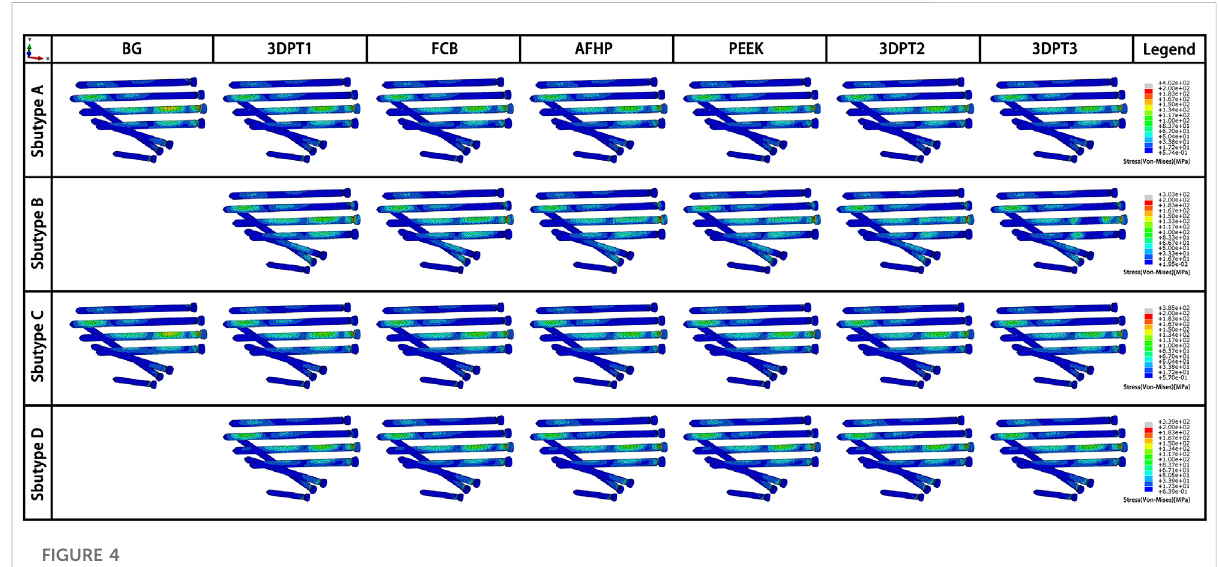
FIGURE 4 Stress fi elds(von Mises)in screw inan oblique downward view for the26simulated scenarios. The maximumstress values in thescrew for each subtype were presented in Figure